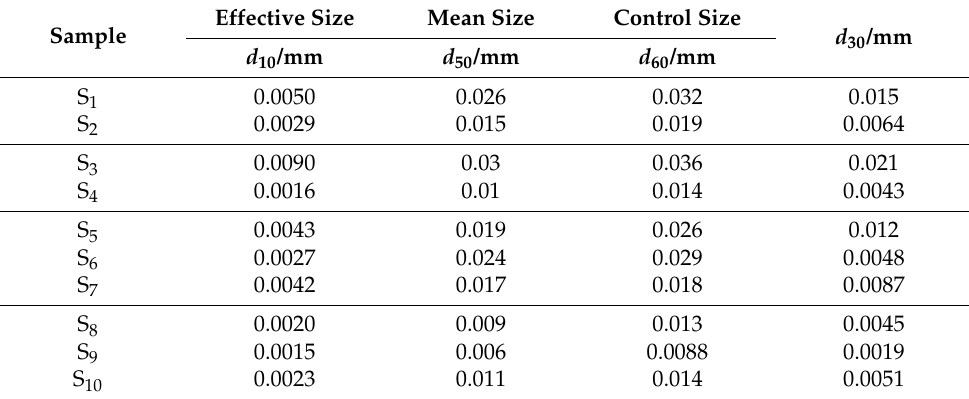
Figure 5. Lake sediments formed in dammed lakes. ( a ) In WDL-RCR reach; ( b ) in WDL-RCR reach; ( c ) in RCR-SWL reach. Table 1. Characteristic parameters of cumulative percentage curves of lacustrine